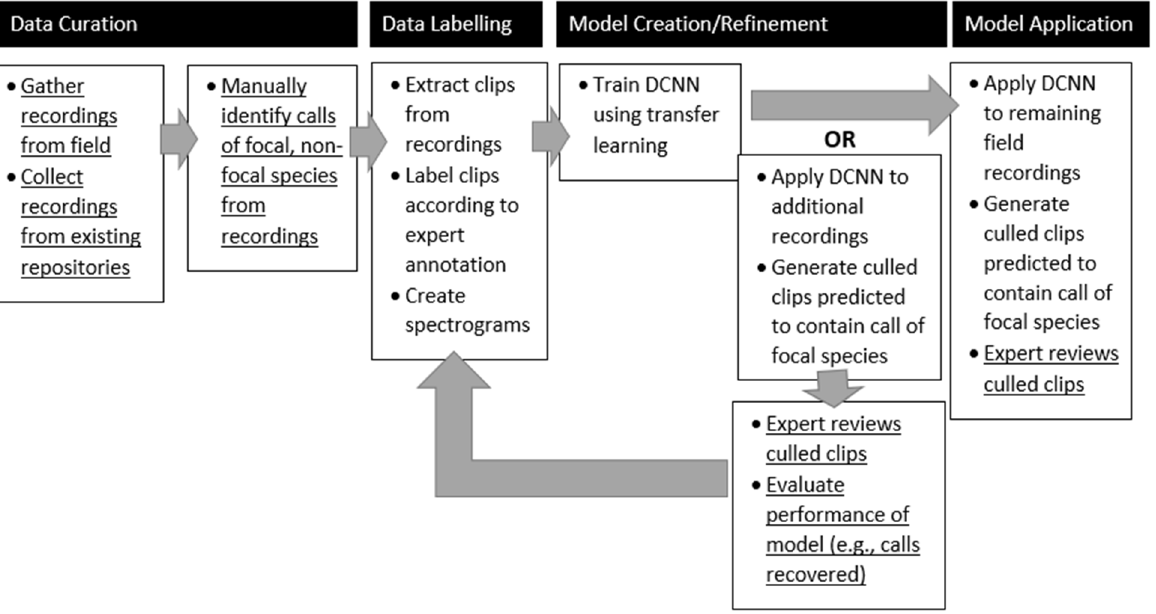
Figure 2. An overview of the workflow that we used to identify Sora calls from audio recordings. The steps that are underlined were completed by an ornithologist and the other steps by computer scientists.